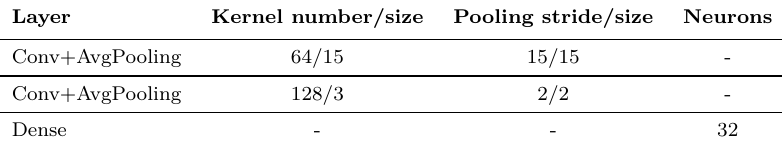
Table 2: Triplet architectures used in the